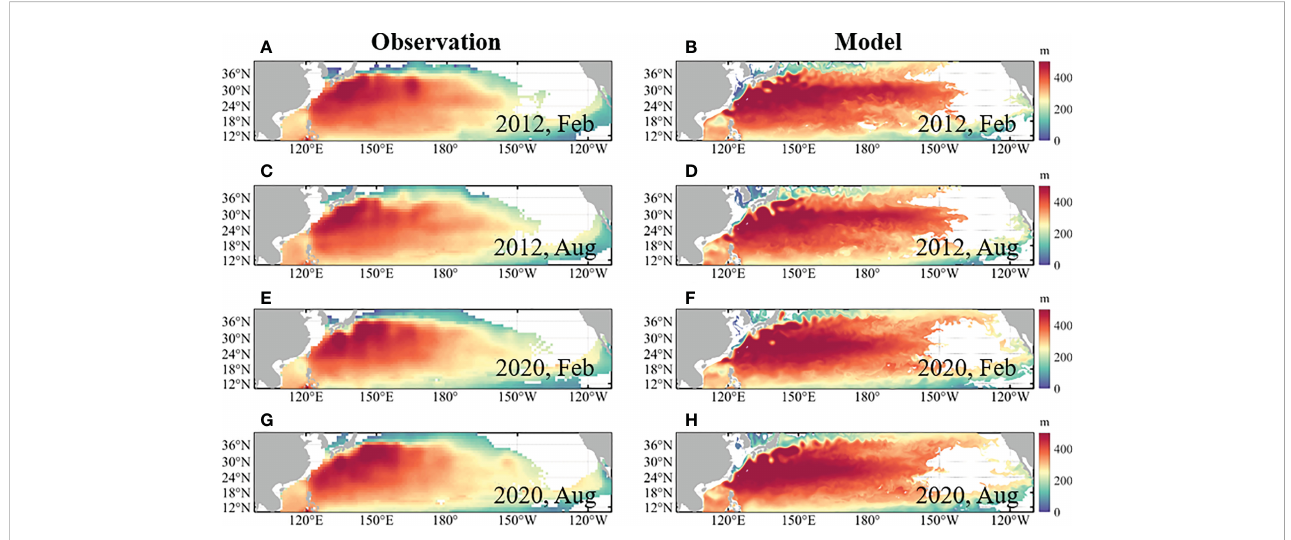
FIGURE 4 Comparison of the mid-depth of CMW between (A, C, E, G) EN4 and (B, D, F, H) the model result in (A, B) February 2012, (C, D) August 2012, (E, F) February 2020, and (G, H) August 2020. CMW was de fi ned by a temperature of 10.0 – 14.5 °C and salinity of 34.3 – 34.6